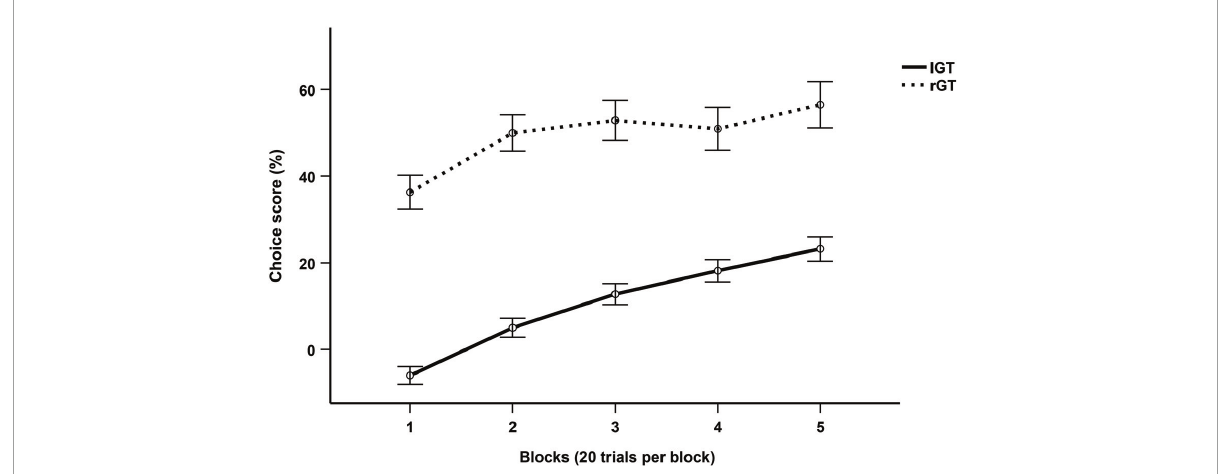
FIGURE2 Mean choice score per 20-trial block across the first 100 trials of the IGT and rGT. Data are presented as mean ± 1 standard error (SE).